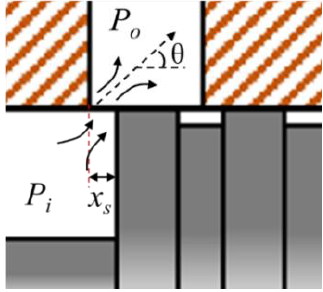
Figure 3. Hydraulic model of the spool valve.